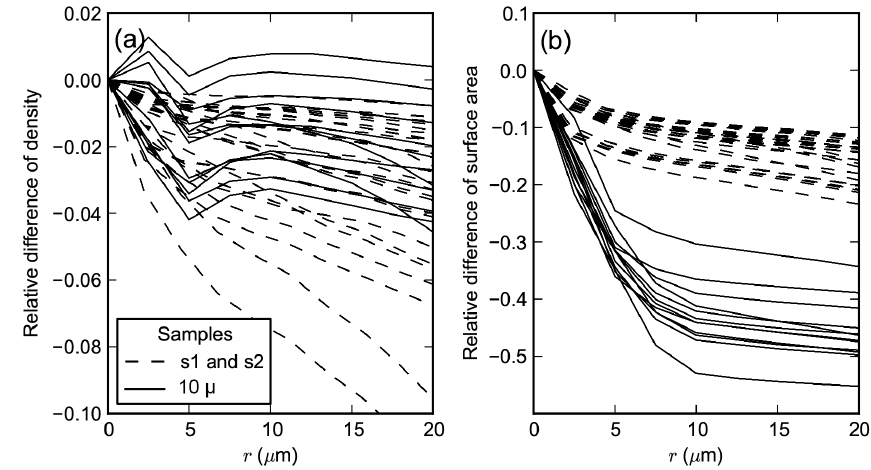
Figure 13. Energy-based segmentation: relative variations of density (a) and surface area (b) as a function of parameter r